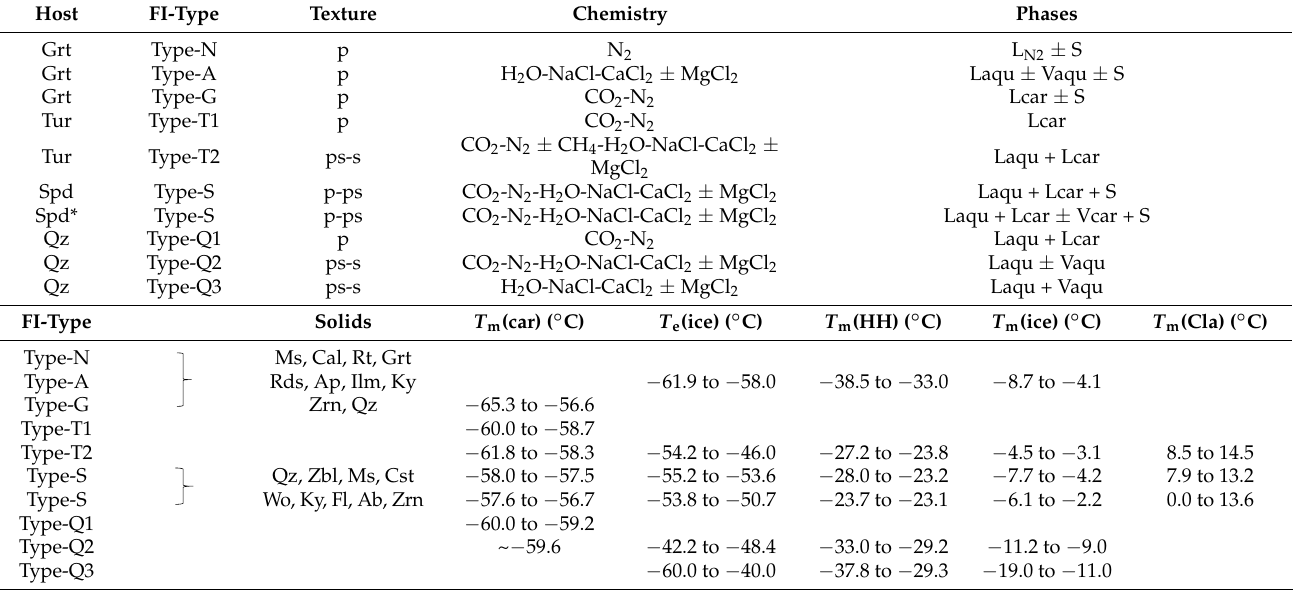
Table 1. Summary of fluid inclusion properties.